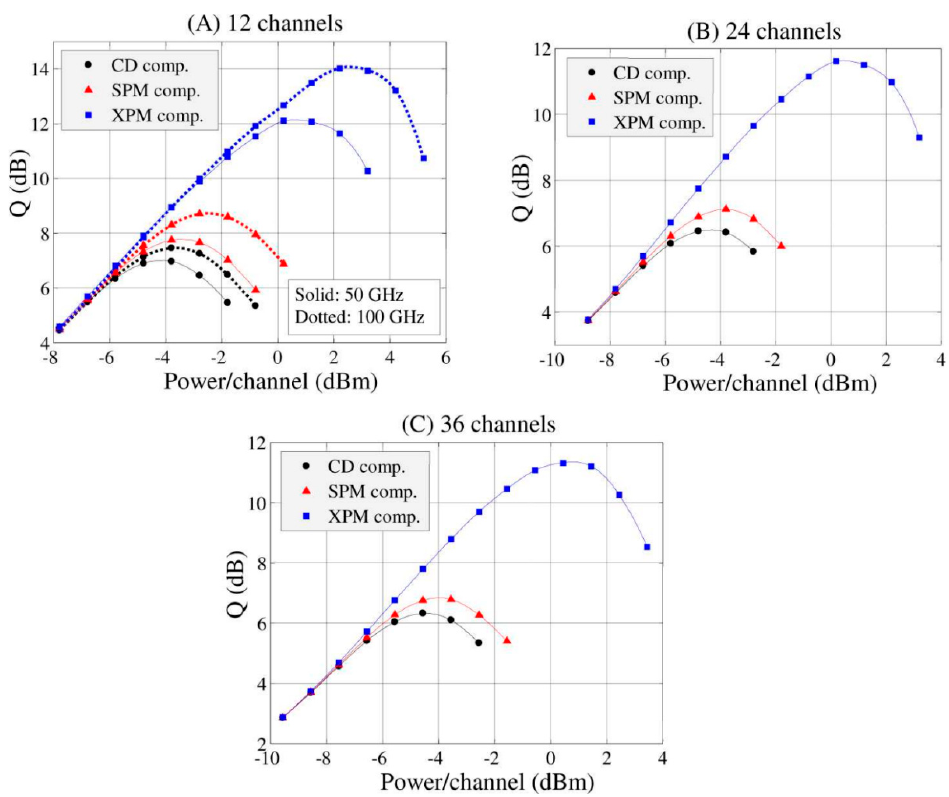
Figure 11. Performance results for: ( A ) 12 channels, ( B ) 24 channels and ( C ) 36 channels respectively.